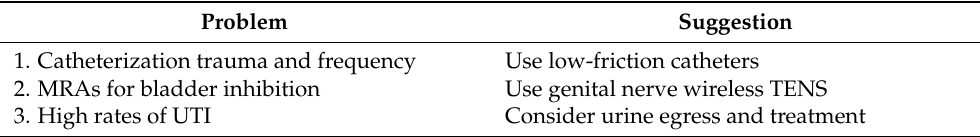
Table 1. For complete UMN SCI, three problems and suggestions for IC